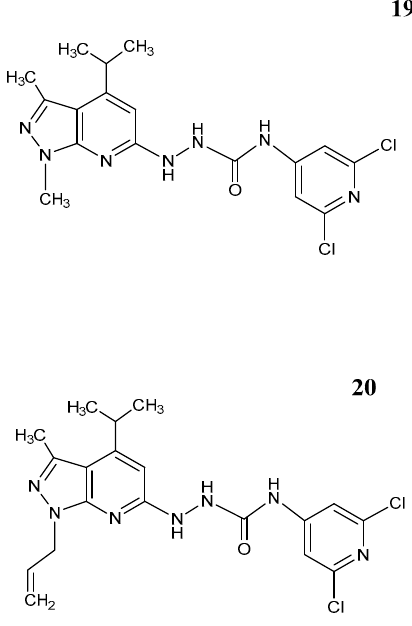
Figure 4. S1P2 receptor antagonists. 19 JTE 013; 20 AB1.